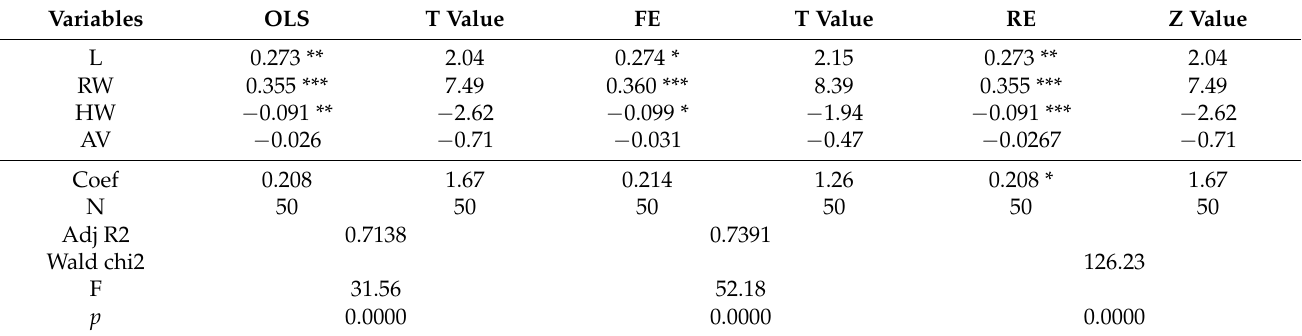
Table 4. Regression results of explanatory variables of OLS, fixed effect, and random